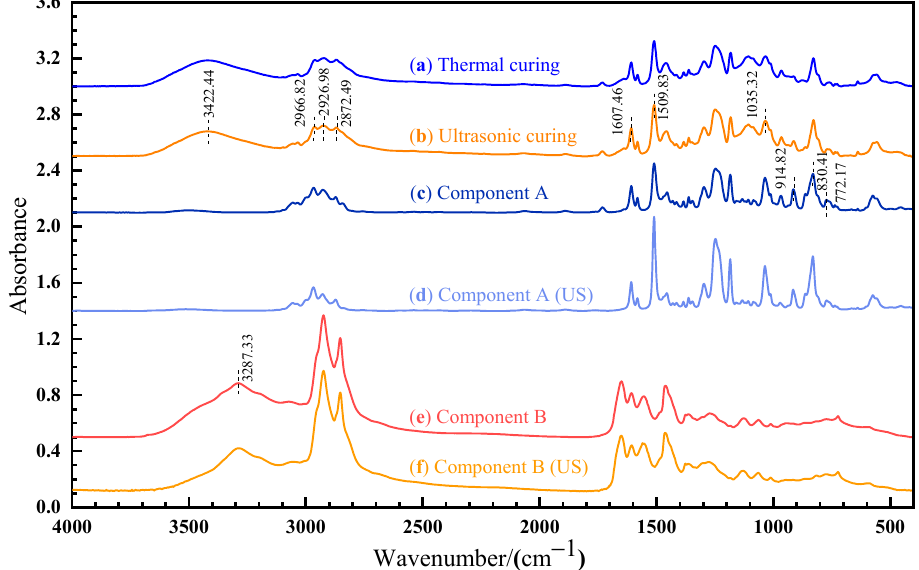
Figure 9. FTIR spectrum of: ( a ) thermal cured sample; ( b ) ultrasonic cured sample; ( c ) component A; ( d ) ultrasonic-treated component A; ( e ) component B; ( f ) ultrasonic-treated component B. In order to evaluate the effect of changes in molecular structure under ultrasonic on the chemical reactivity of the epoxy/amine system, density functional theory (DFT) was